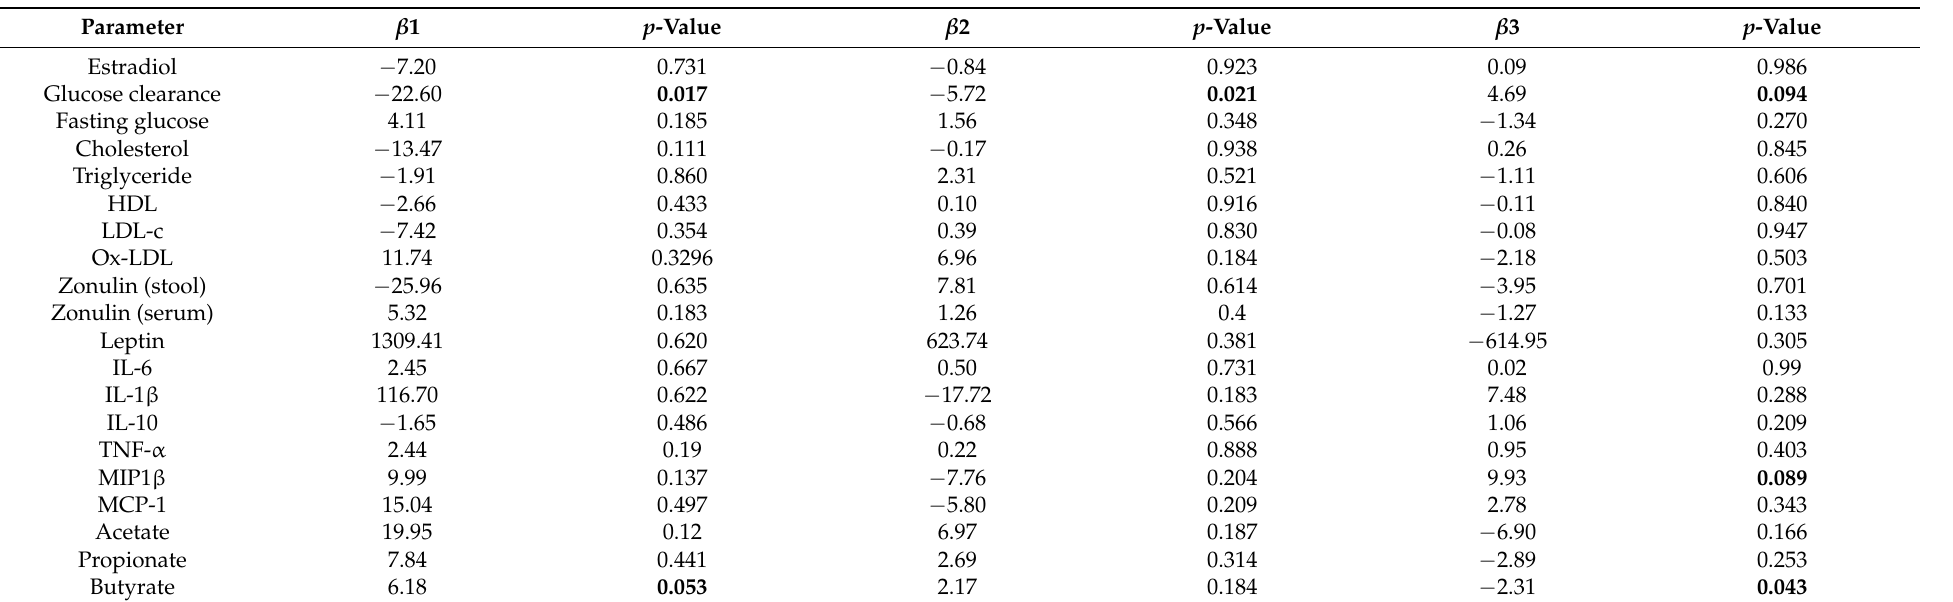
Table A3. GEE results for clinical parameters (FVC vs.